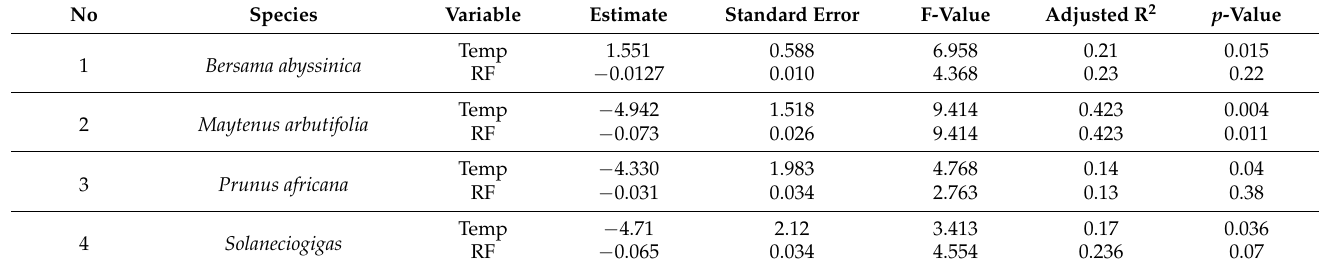
Table 1. The linear regression model showing the effect of mean monthly temperature ( ◦ C) and rainfall (mm) on the flowering percent of species.